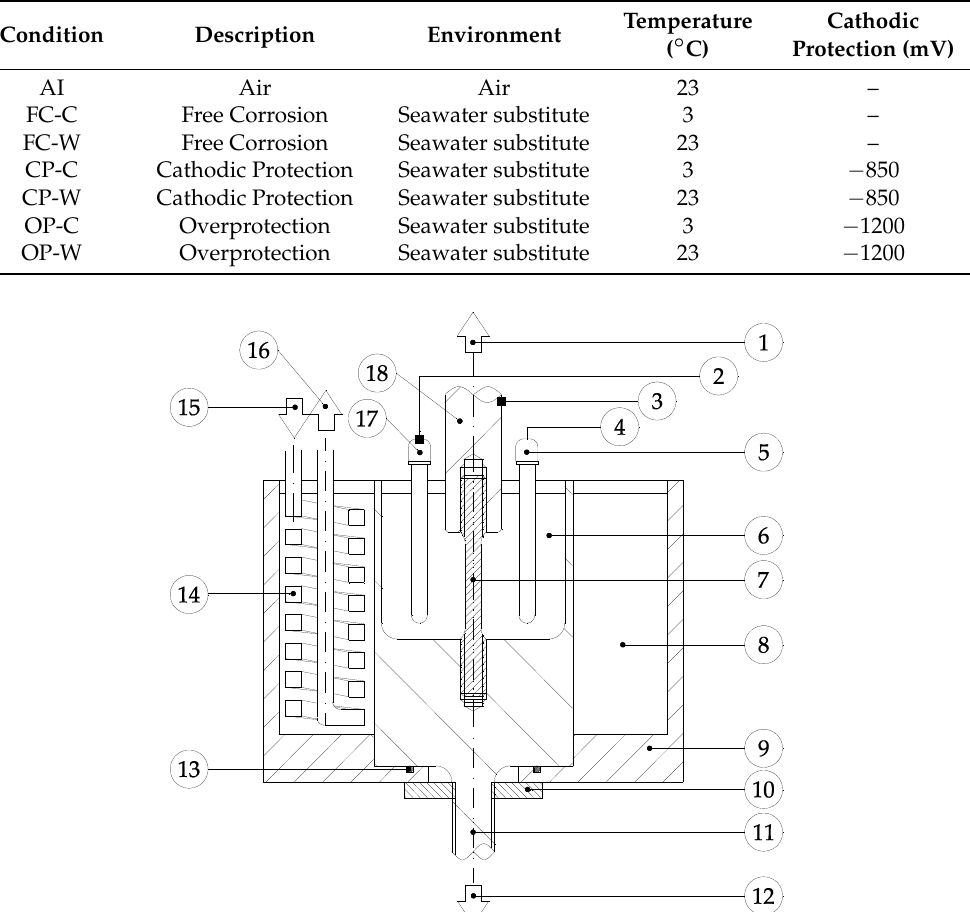
Figure 3. Testing scheme for Slow Strain Rate Tensile (SSRT) tests carried out in seawater substitute at IK4-AZTERLAN facilities. (1. Connection to the testing machine. 2. Connection to the multi-meter. 3. Connection to the voltage source and the multi-meter. 4. Connection to the voltage source. 5.